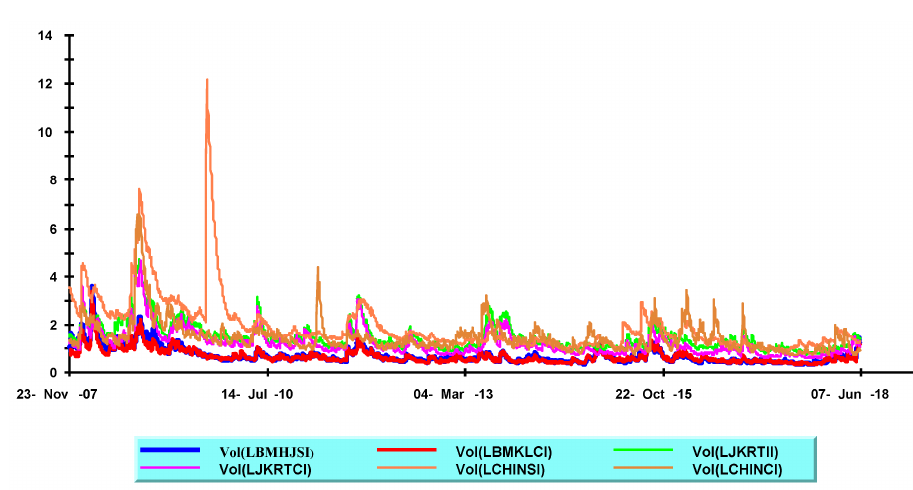
Figure 6. Conditional volatility in emerging markets.